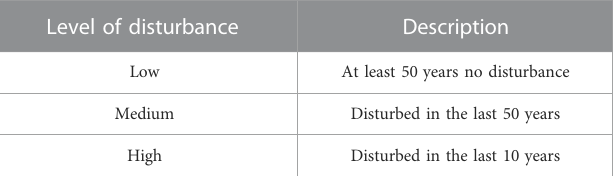
TABLE 1 Assessment of level of disturbance for each study site is categorized basedonthetimeframesdescribedsincethemostrecentsoildisturbance,based on available history of land use. Disturbance was considered to be land that has undergone man-made changetosoil ’ ssurface layer byphysicaldisruptionofthe soil structure and ecosystem, such as tillage or